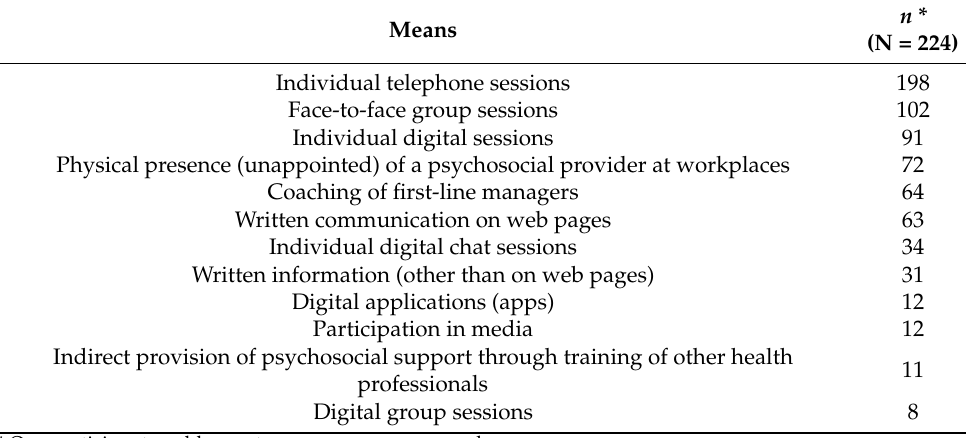
Table 4. Means of providing psychosocial